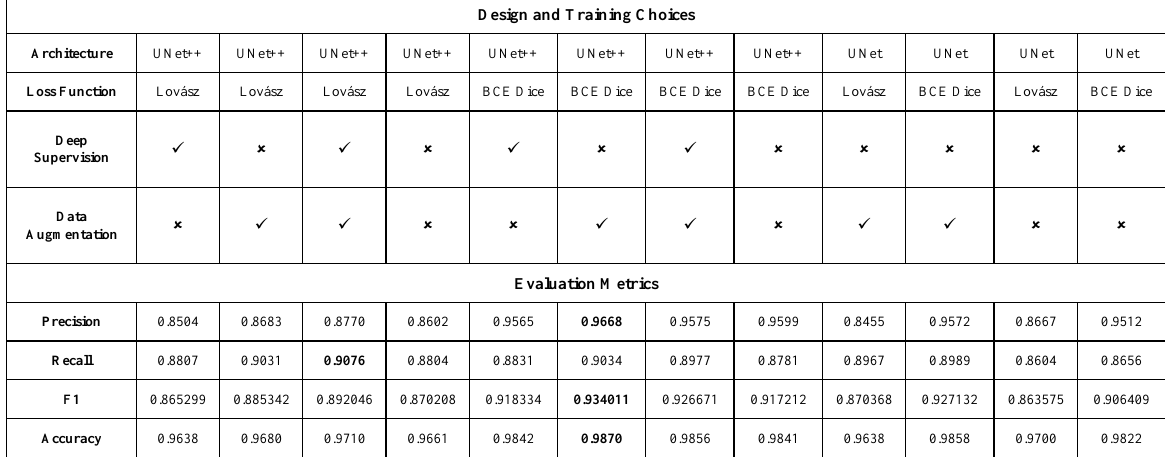
Table 1: Results Summary. Evaluation metrics for various choices regarding the architecture of the network, the loss function being used for training and the use of deep supervision and data augmentation during